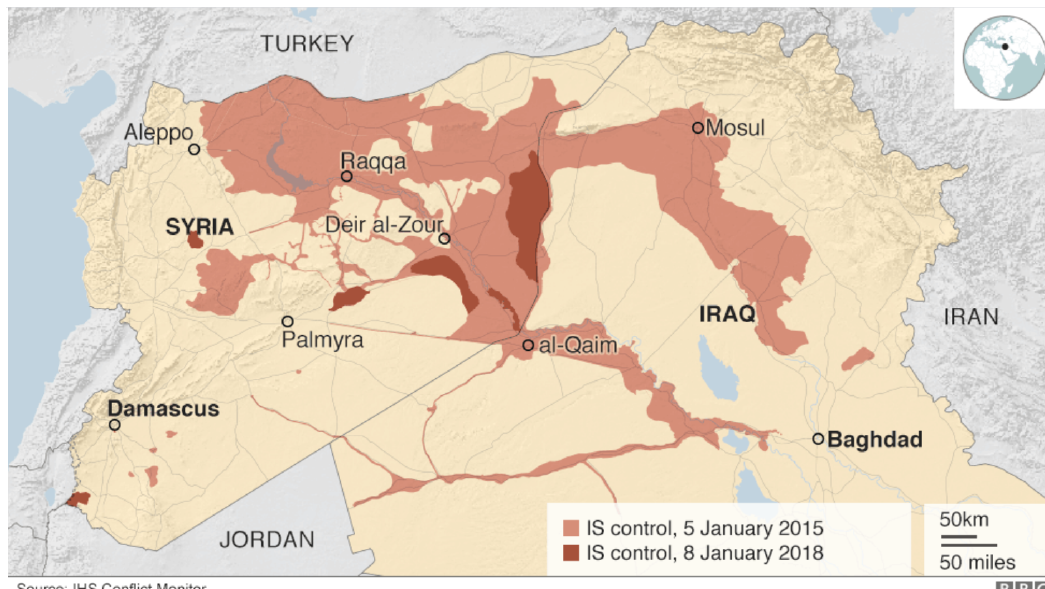
Figure 1. ISIL territory control between 2015 and 2018